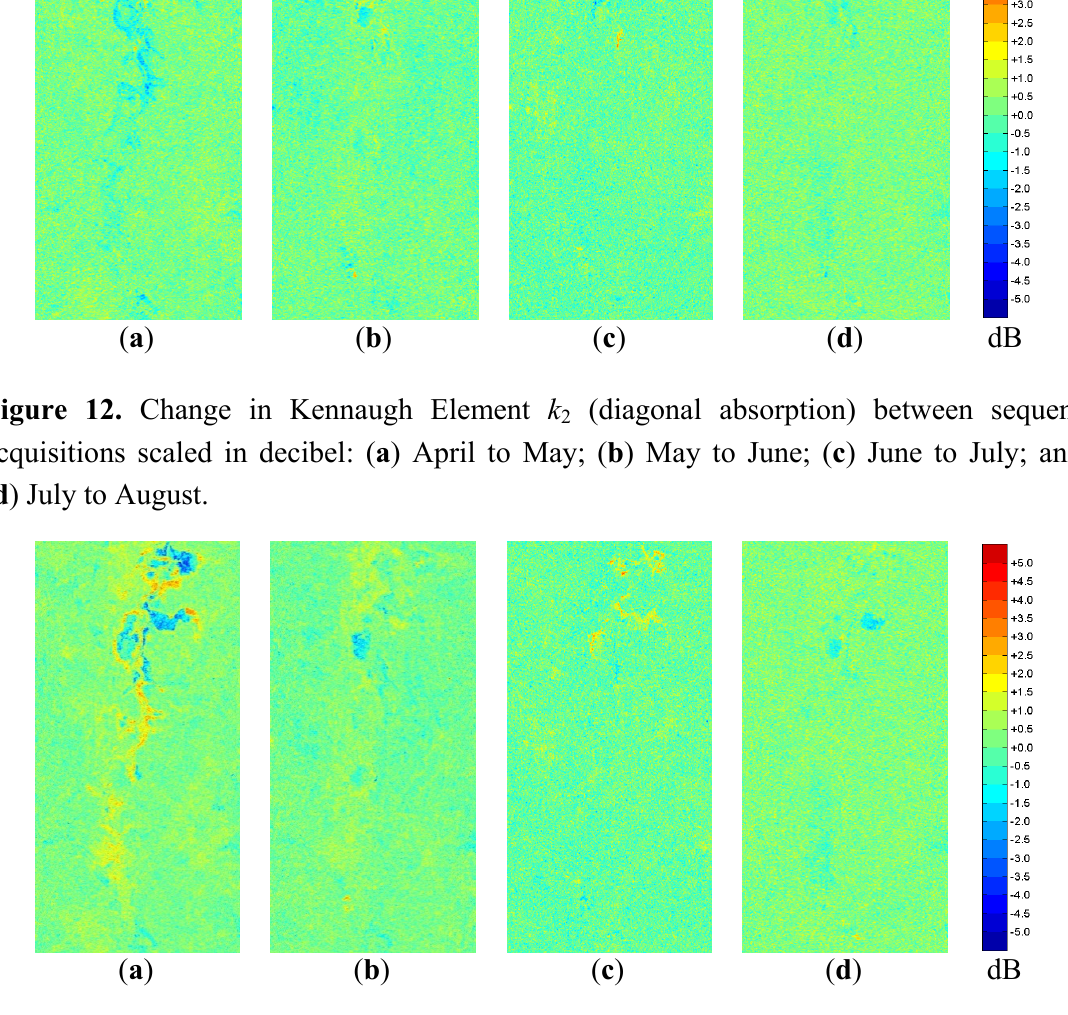
Figure 13. Change in Kennaugh Element k (circular absorption) between sequent acquisitions 3 scaled in decibel: ( a ) April to May; ( b ) May to June; ( c ) June to July; and ( d ) July to